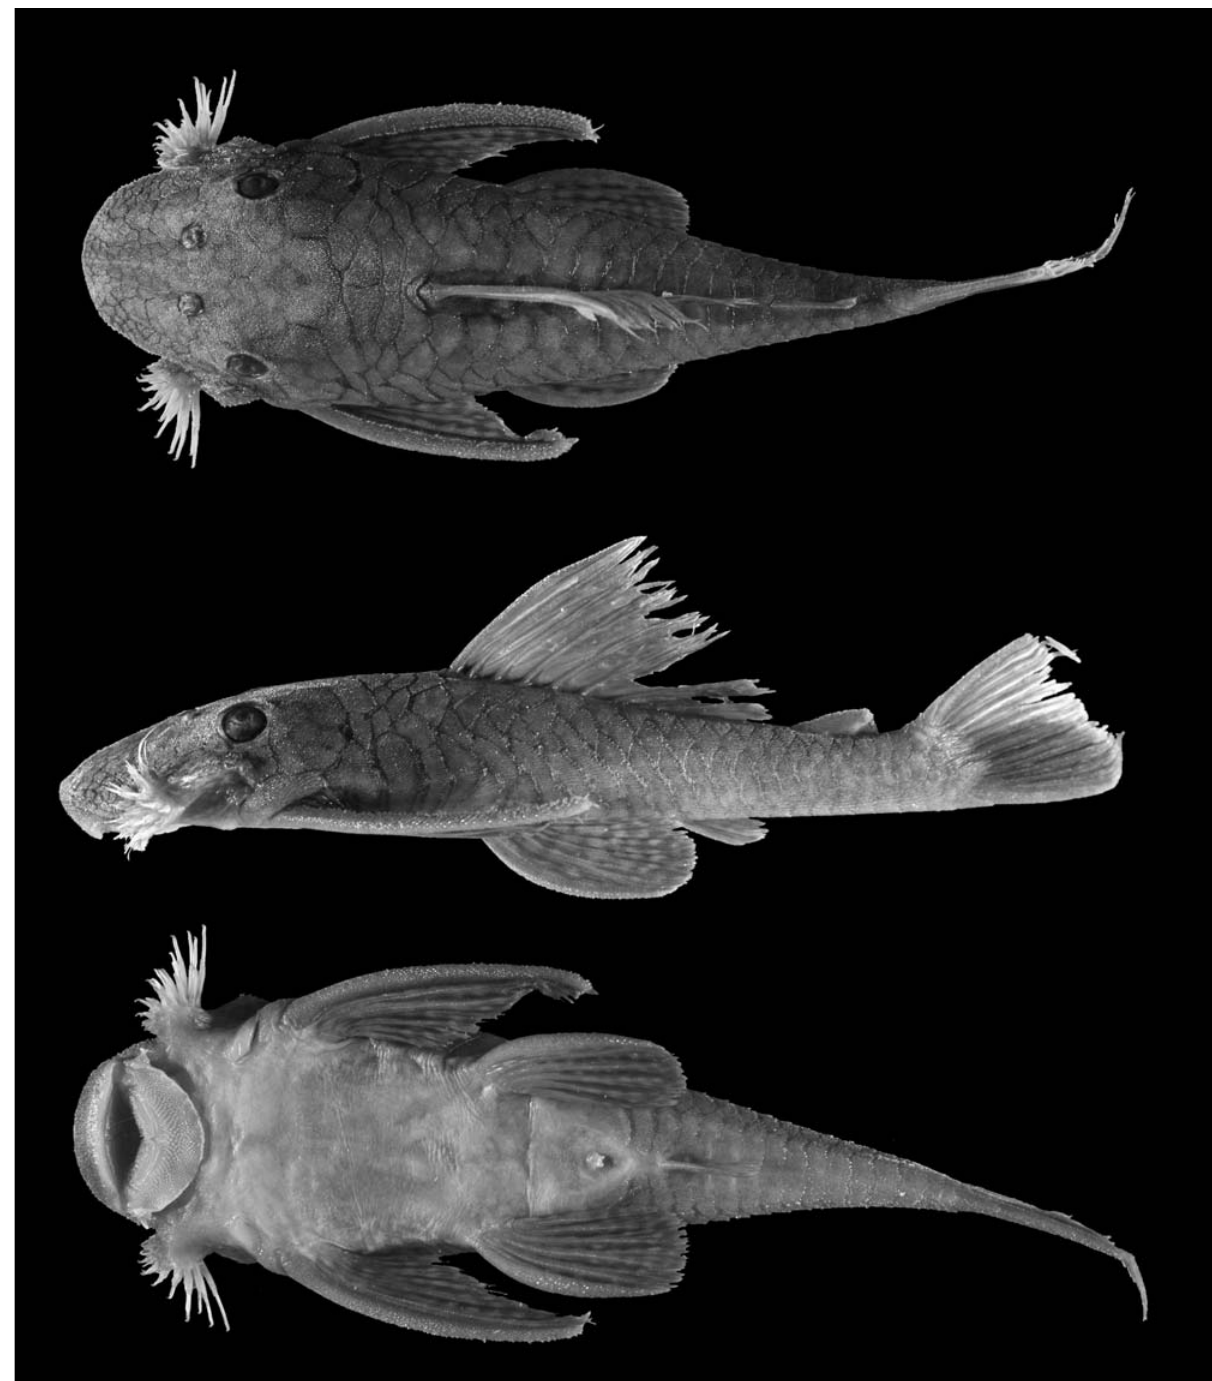
Fig. 7. Dorsal, lateral, and ventral views of holotype of Lasiancistrus saetiger , MCP 37942, 100.1 mm